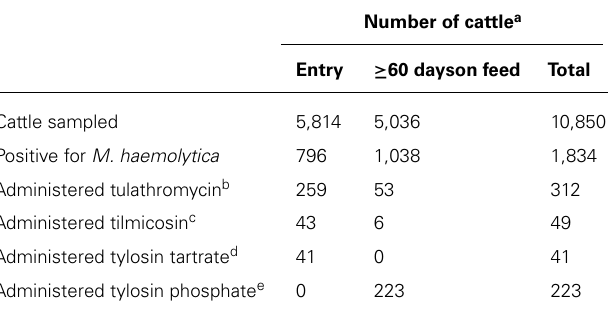
Table 3 | History of macrolide use in feedlot cattle that were positive for M. haemolytica over a 3-year period. Number of cattle